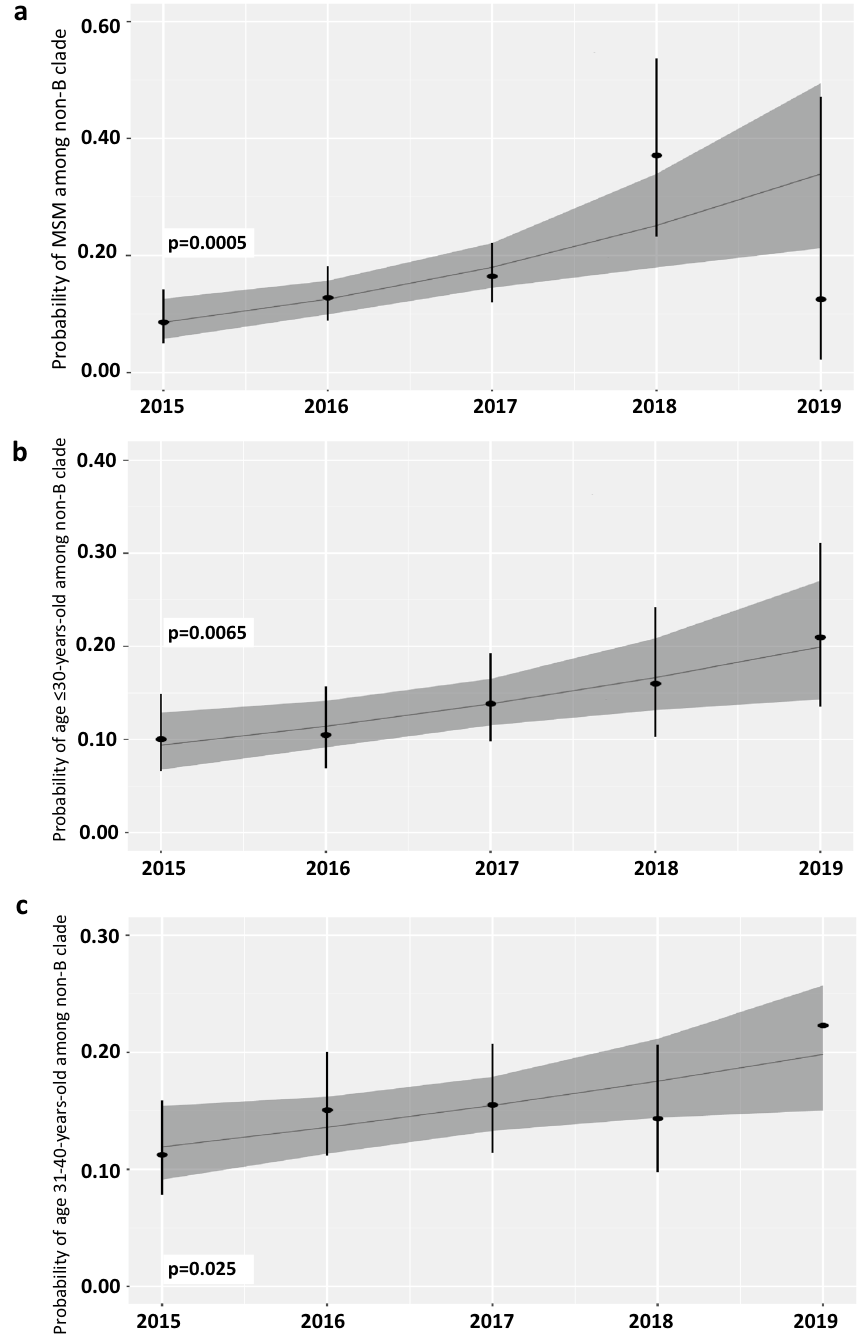
Figure 9. Logistic regression estimates for time trends between 2015–2019 for transmission category: men who have sex with men (MSM) ( a ), age at diagnosis for ≤ 30 years-old group ( b ) and 31–40 years-old group ( c ). Dots indicate the percentage per year and vertical bars 95% confidence intervals for the percentages with a vertically presented logistic regression time trend line with dark-grey shaded 95% confidence intervals for the regression